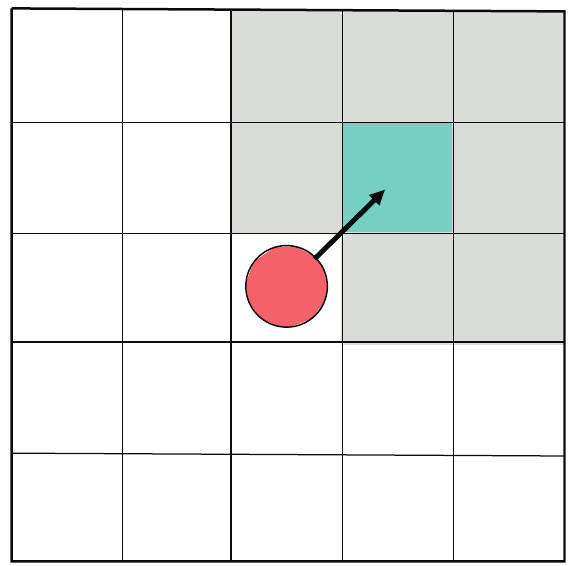
Figure 10: Density range observed for